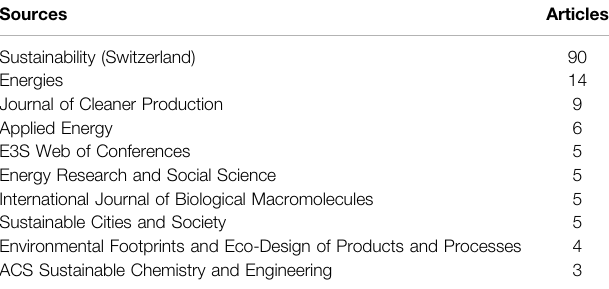
TABLE 3 | Most contributing sources.